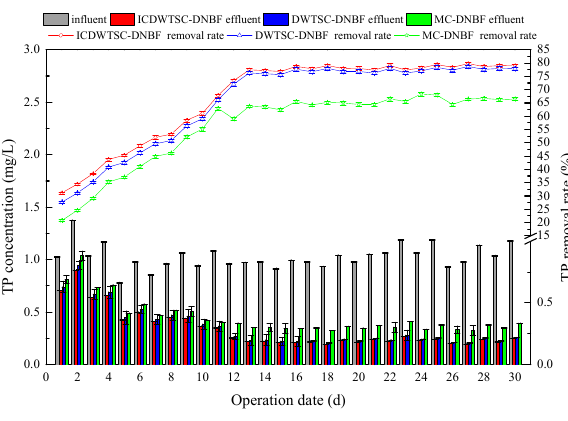
Figure 4. The P removed in three systems.